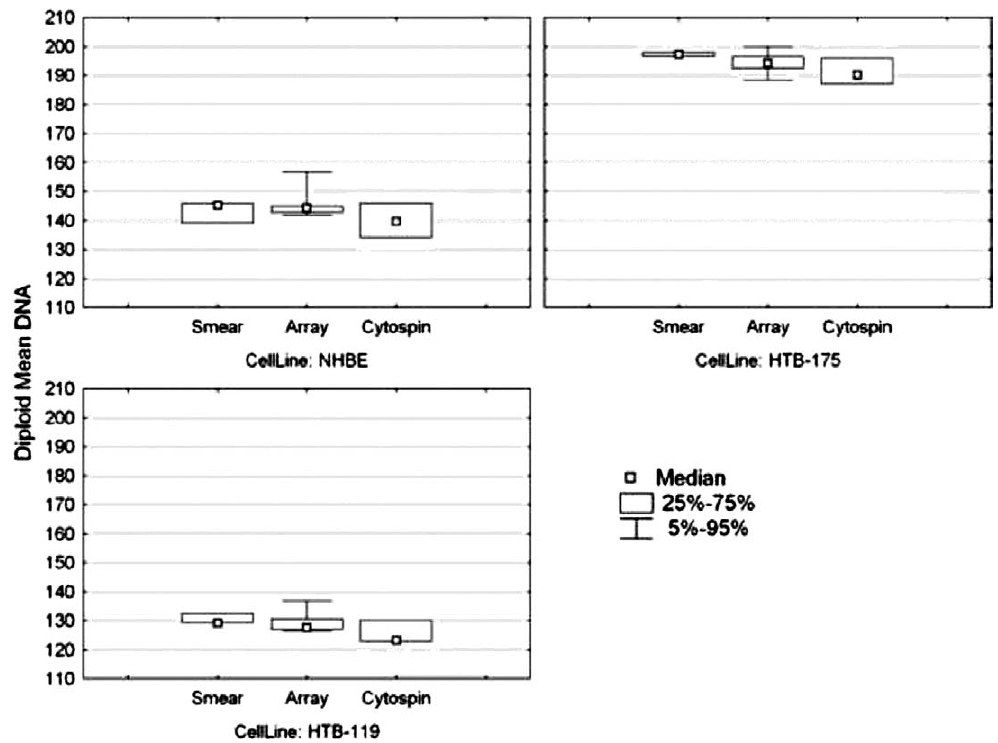
Fig. 6. Three different cell lines showing diploid mean DNA amount for three different preparation methods (smear, array and cytospin). Note the variation between samples is much larger than the variation within or between sample